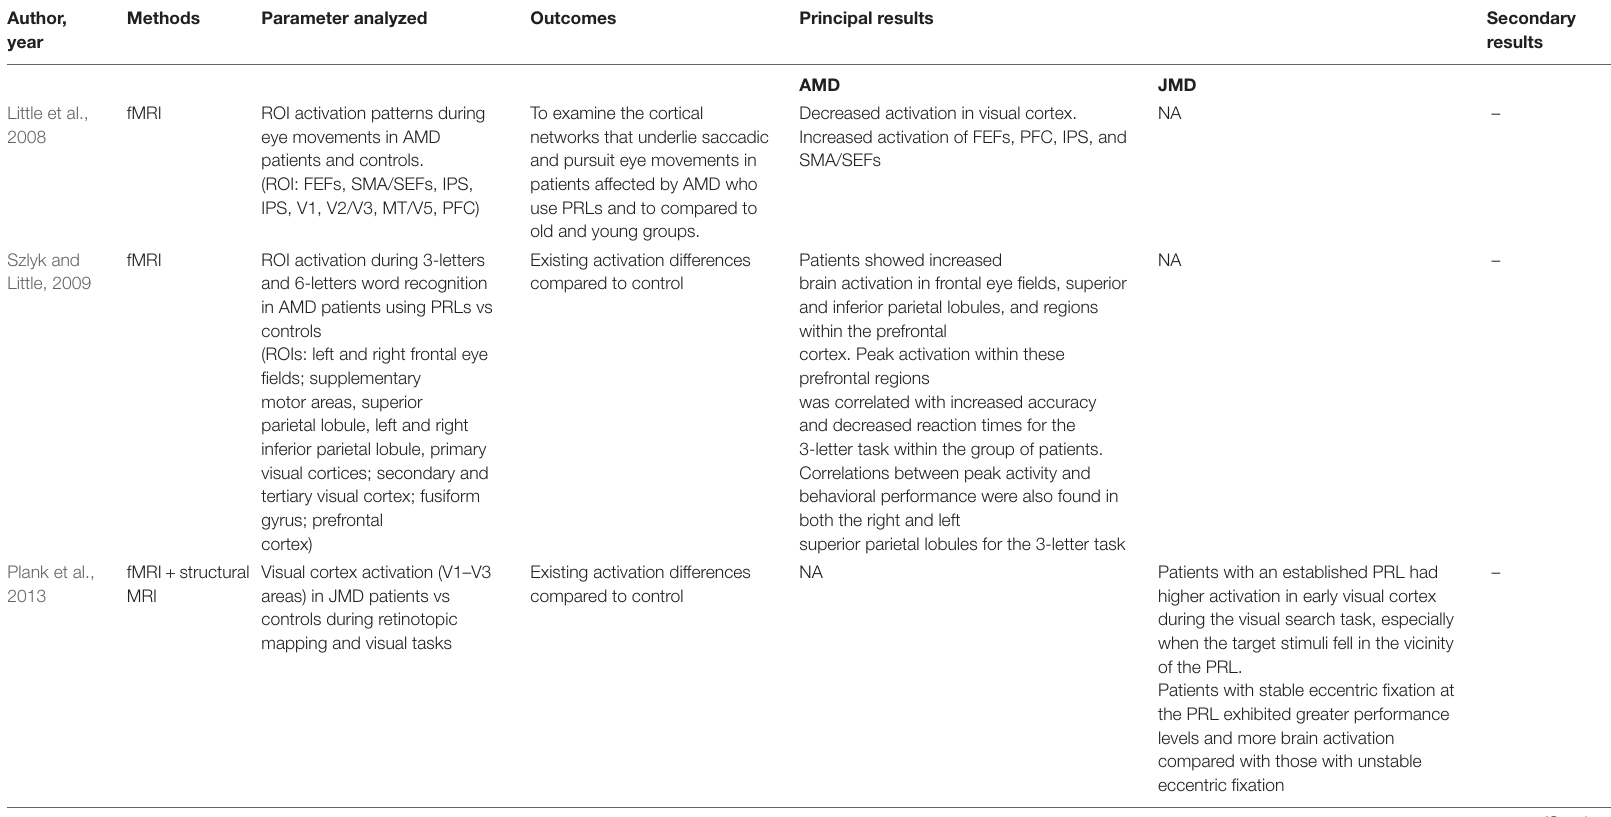
TABLE 3 | Outcomes of functional